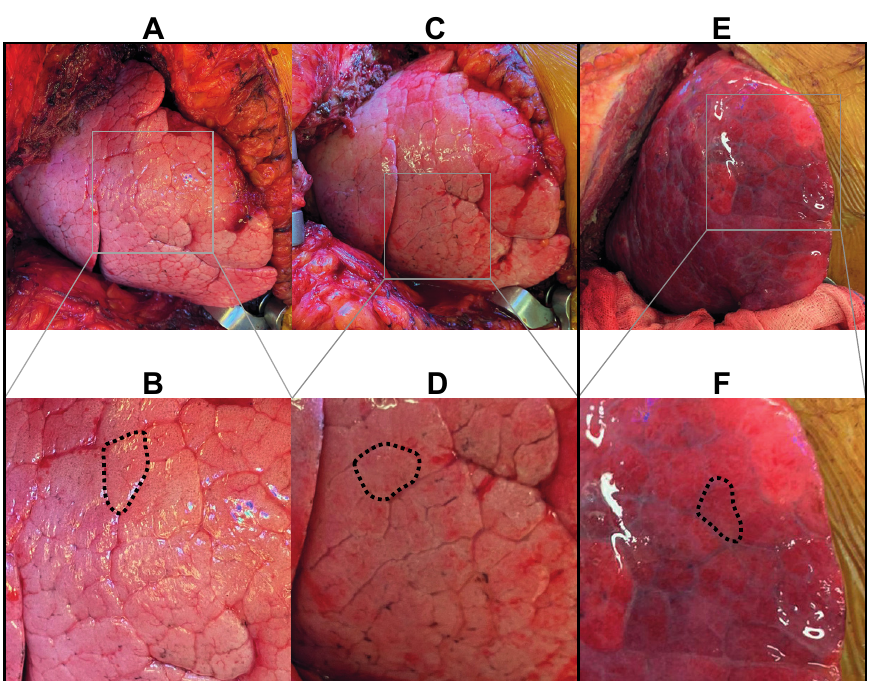
Figure 5. ( A – D ) Macroscopic view on the right lung after reperfusion and reinflation in a case without lung edema after LTx (PGD grade 0 T0–T72; PaO 2 /FiO 2 91 at T0, 181 at T24, 286 at T48 and 172 at T72) ( A , B ) View on the lung immediately after reperfusion and reinflation. The interlobular septa can be appreciated below the visceral pleura and are slender (dashed line). ( C , D ) View on the same lung two hours after reperfusion. The septa (dashed line) are clearly distended due to mild interstitial edema but no signs of alveolar edema can be observed. ( E , F ) Macroscopic view on the right lung after reperfusion and reinflation in a LTx case with severe intra- and postoperative edema (PGD grade 3 T0–T72; postoperative ECMO at T0–T72). The edematous, glassy and erythematous aspect of the lung with widened interlobular septa (dashed line) can be appreciated.